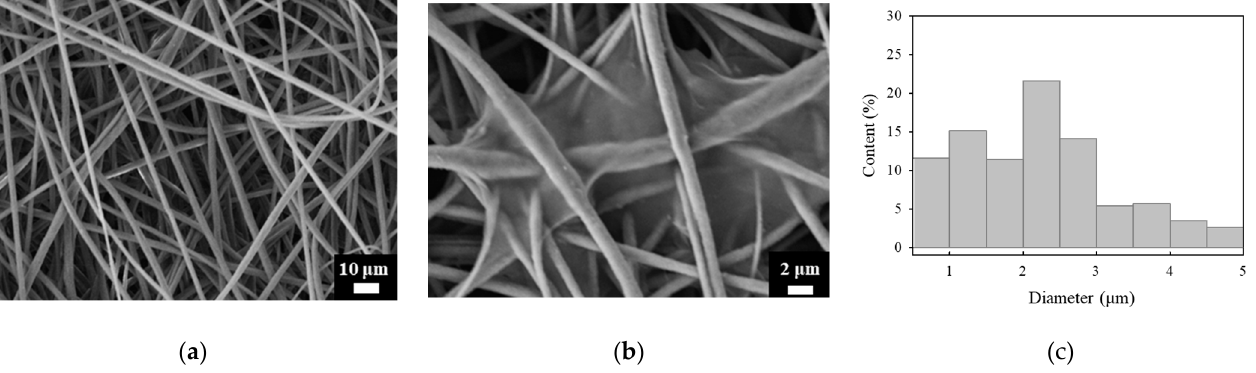
Figure 2. ( a ) FE-SEM image of the PVDF webs before and ( b ) after dip-coating. ( c ) Fiber diameter distribution.